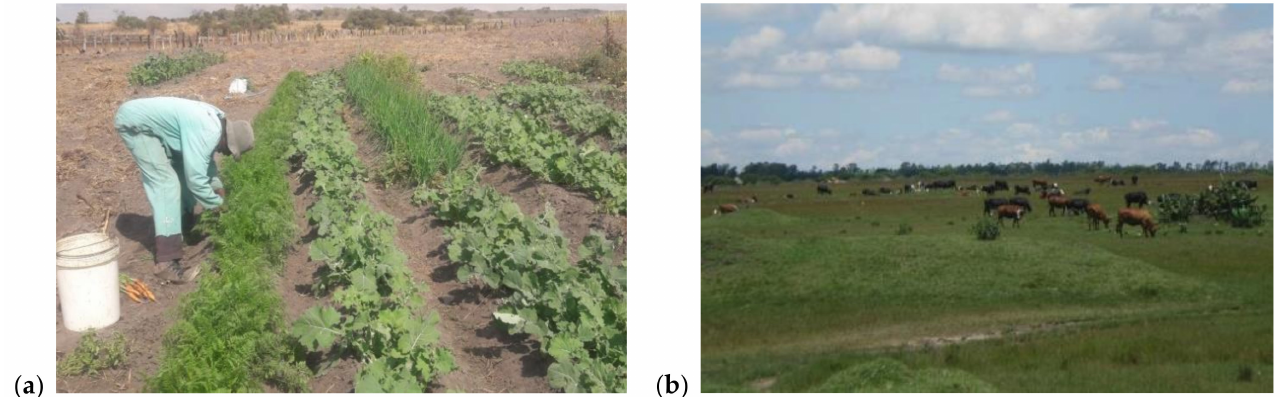
Figure 4. ( a ) Horticultural activities; ( b ) Livestock grazing within the